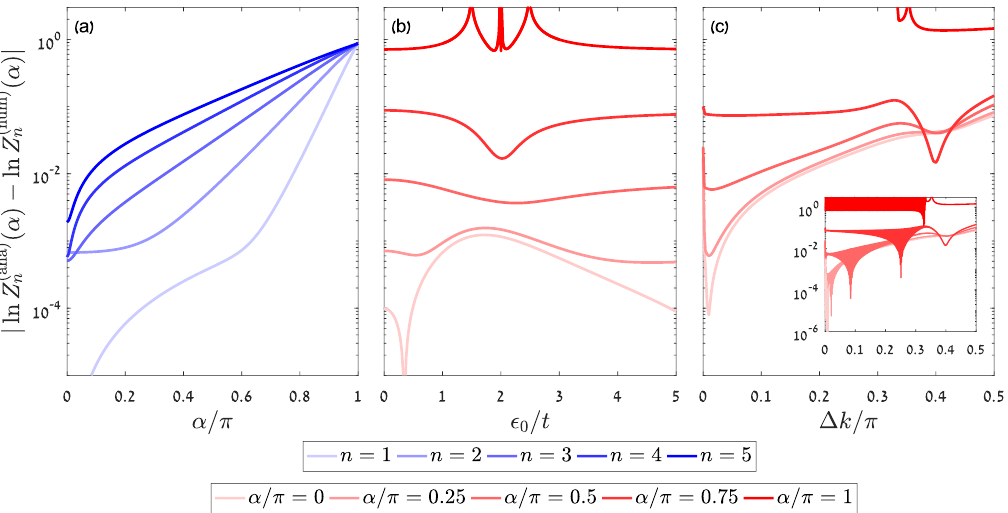
Figure 6: The single impurity model: The absolute deviation of the analytical result ( α ) , given by Eq. (34), from the numerical result ln Z ( num ) ( α ) calculated ln Z ( ana ) n n using Eqs. (17) and (21), in a subsystem of L = 1000 sites. In the different panels, the absolute deviation is presented (a) as a function of α for various fixed values of = t , k = π/ 2 and k − k = 0.1; (b) as a function of ε / t for various n , with ε F , R F , L F , R 0 0 = π/ 2 and k − k = 0.1; and (c) as a function fixed values of α , with n = 2, k F , R F , L F , R − k = t and k = π/ 2. of ∆ k = k for various fixed values of α , with n = 2, ε F , L F , R F , R 0 In (c) the results oscillate rapidly with varying ∆ k , so only the top envelope of these oscillations (designating the local maximum of the deviation) is shown, while the inset shows the full oscillations (for α = π there is a regime of ∆ k for which at ( α = π ) vanishes while each period of the oscillation there is a point where Z ( num ) n ( α = π ) does not, and therefore the top envelope is infinite and is not Z ( ana ) n